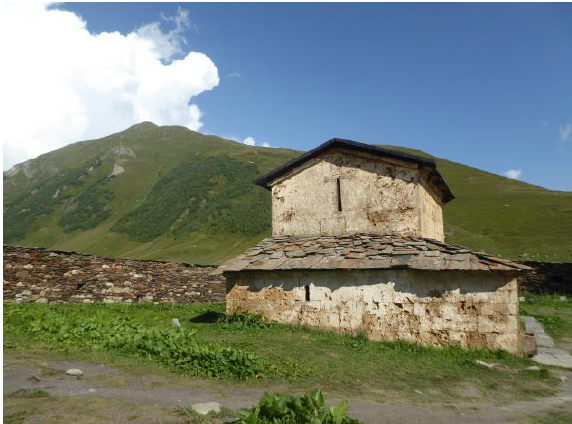
Figure 7. Lamaria at St. Georges Church, Zhibiani, Upper Svaneti, CI-ESG,